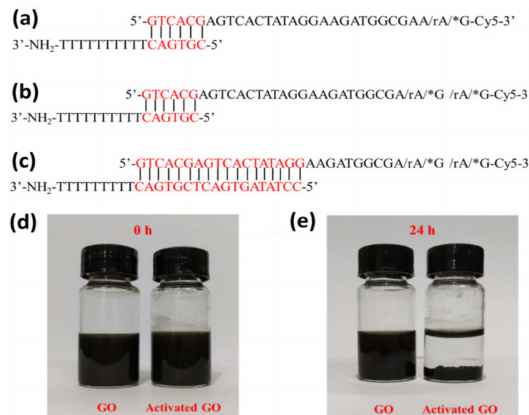
Figure 1. DNA sequence I hybrid with one PS cutting site ( a ) and two PS cutting sites ( b ). ( c ) DNA sequence II hybrid with two PS cutting sites. Digital images with comparison of GO and activated GO: ( d ) at the beginning and ( e ) after 24